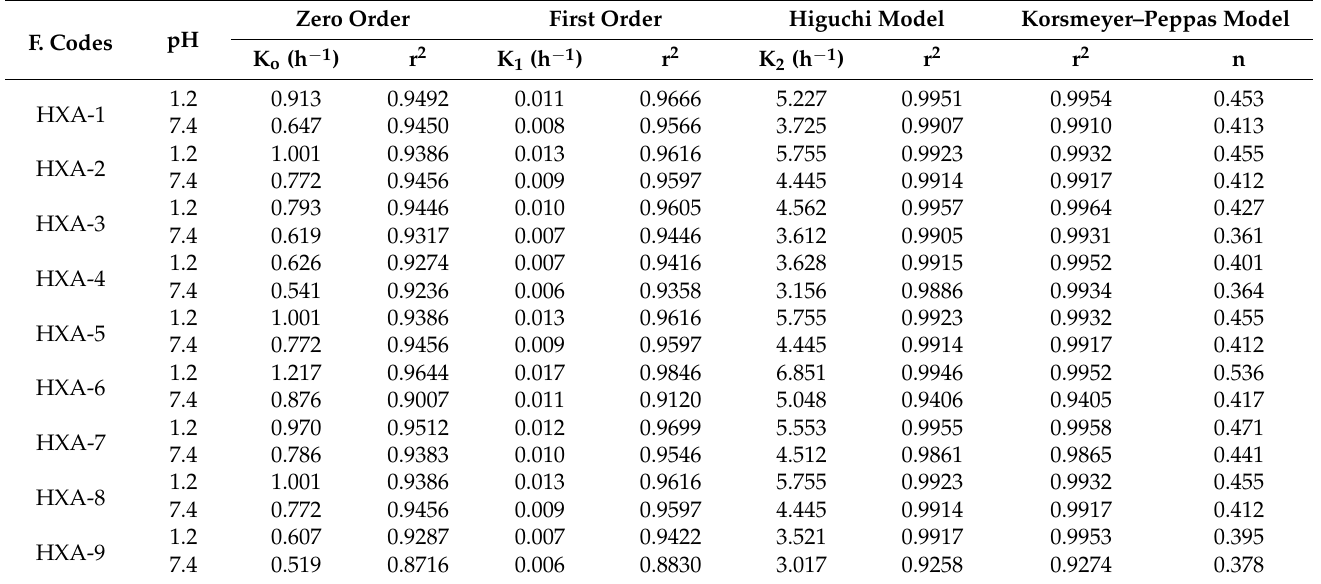
Figure 10. The drug release curve of hydrogel under pH conditions of 1.2 ( A ) and 7.4 ( B ). Table 5. The release kinetics of rutin from xanthan gum-based (HPMC- g -AMPS) hydrogels crosslinked with EGDMA at different pH levels.